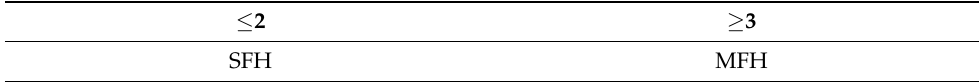
Table 5. Building’s classification according to the number of